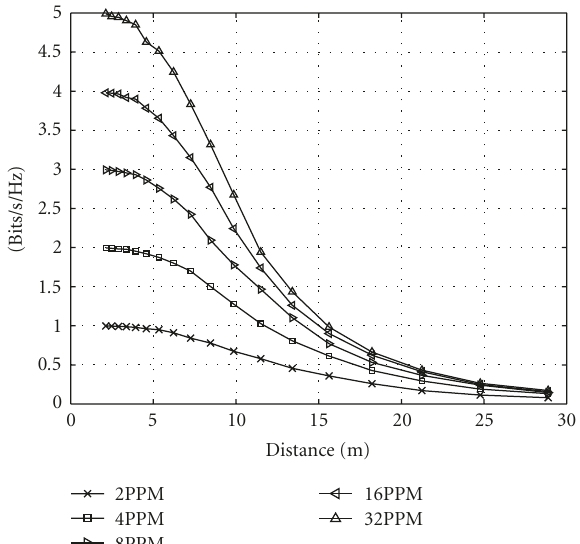
Figure 5: Relationship between distance and channel capacity of a UWB system with PPM over a multipath fading channel, L = 2, m = 0 . 65, and n = 3.